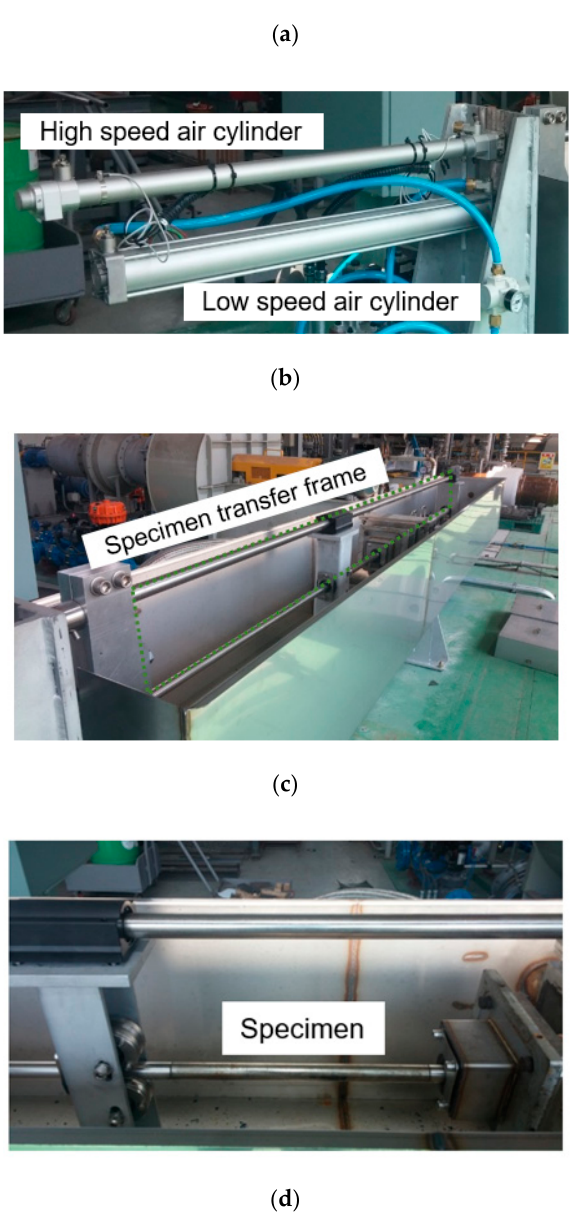
Figure 7. ( a ) Schematic of TPS system; ( b ) dual cylinder; ( c ) specimen transfer frame; ( d ) screw type specimen clamping